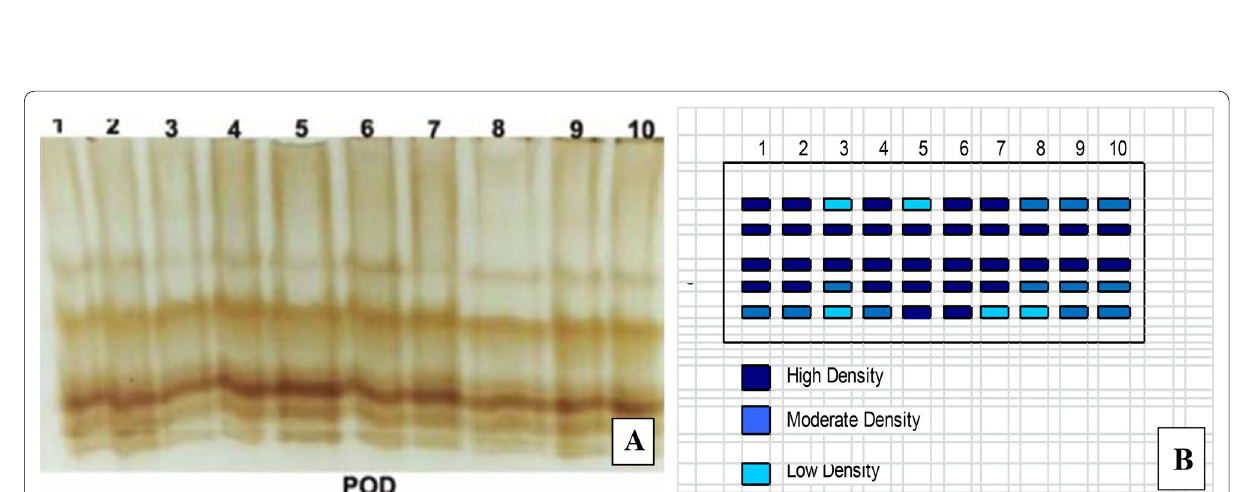
Fig. 6 Effect of F. oxysporum and endophytic isolates on peroxidase isozyme of tomato plants. A POD, B Ideogram analysis of POD isozyme (T1-Healthy control; T2-Infected control; T3-Healthy treated with A. flavus ; T4-Healthy treated with A. nidulance ; T5-Healthy treated with A. fumigatus ; T6-Healthy treated with combination of A. flavus, A. nidulance and A. fumigatus ; T7-Infected treated with A. flavus ; T8-Infected treated with A. nidulance ; T9-Infected treated with A. fumigatus and T10-Infected treated with combination of A. flavus, A. nidulance and A. fumigatus